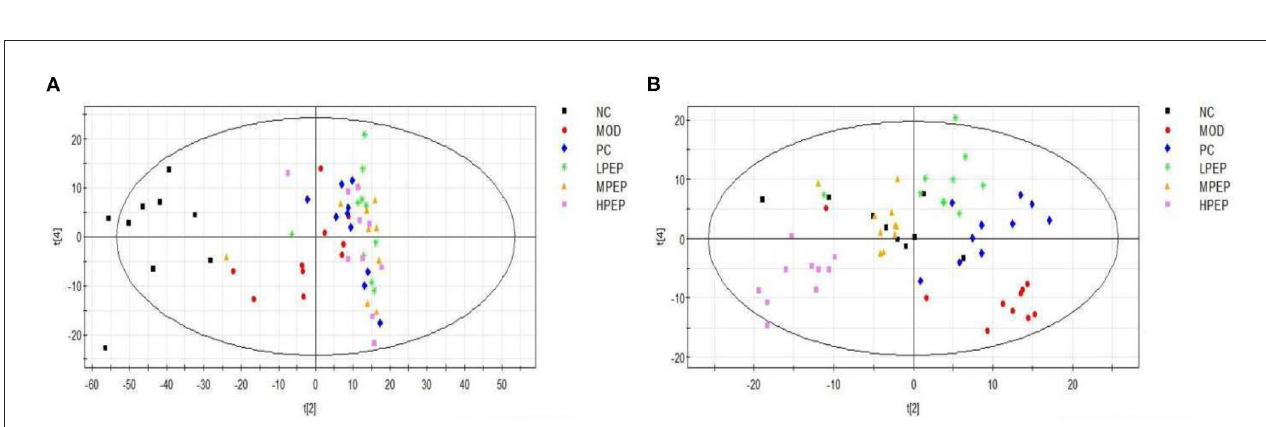
FIGURE6 PCA (A) and PLS-DA (B) scores of serum samples from different groups of mice (positive); NC, Normal control group; MOD, model group; PC, positive control group; LPEP, low-dose polysaccharide group (50 mg/kg); MPEP, medium-dose polysaccharide group (100 mg/kg), (and HPEP, high-dose polysaccharide group (200